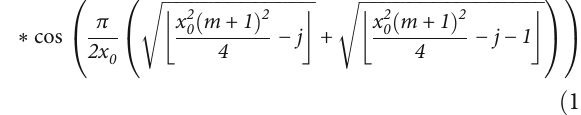
ffiffiffiffiffiffiffiffiffiffiffiffiffiffiffiffiffiffiffiffiffiffiffiffiffiffiffiffiffiffiffiffiffi x 2 m + 1 ð 0